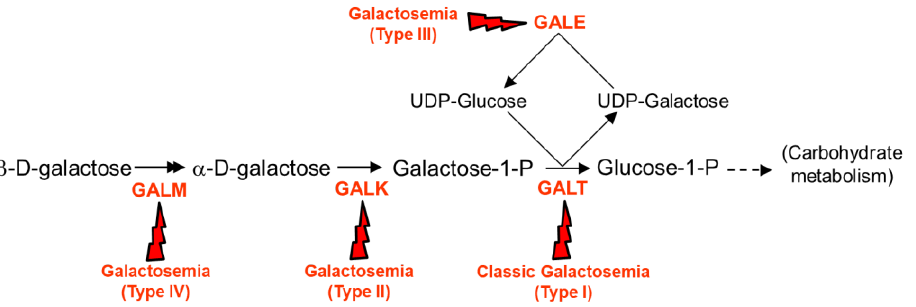
Scheme 1. Leloir pathway of galactose metabolism. The enzymes catalyzing the different steps are galactose mutarotase (GALM), galactokinase 1 (GALK), galactose-1-phosphate uridylyltransferase (GALT), and UDP-galactose 4-epimerase (GALE). Different forms of galactosemia derive from the impairment of each enzyme, as represented in the scheme.